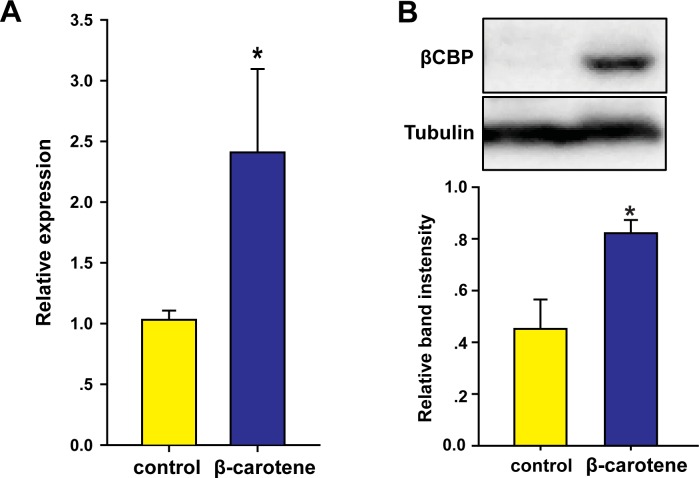
βCBP expression in the tergum of the thorax and abdomen of solitary locusts.(A, B) mRNA (A) and protein (B) expression levels of βCBP were determined in solitary nymphs after feeding with β-carotene followed by crowding. Controls were fed with a regular diet without β-carotene and were crowded afterward. qPCR data are shown as the means ± SEM (n = 6). Western blot bands were quantified using densitometry, and the values are expressed as the means ± SEM (n = 3); *p < 0.05.